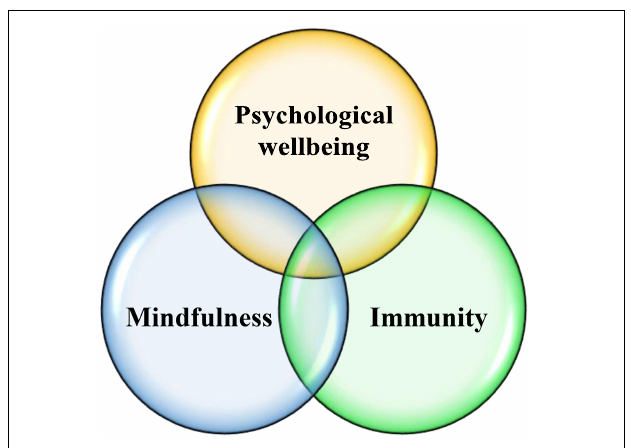
FIGURE 2 | The relationship between the psychological wellbeing, mindfulness, and immunity of